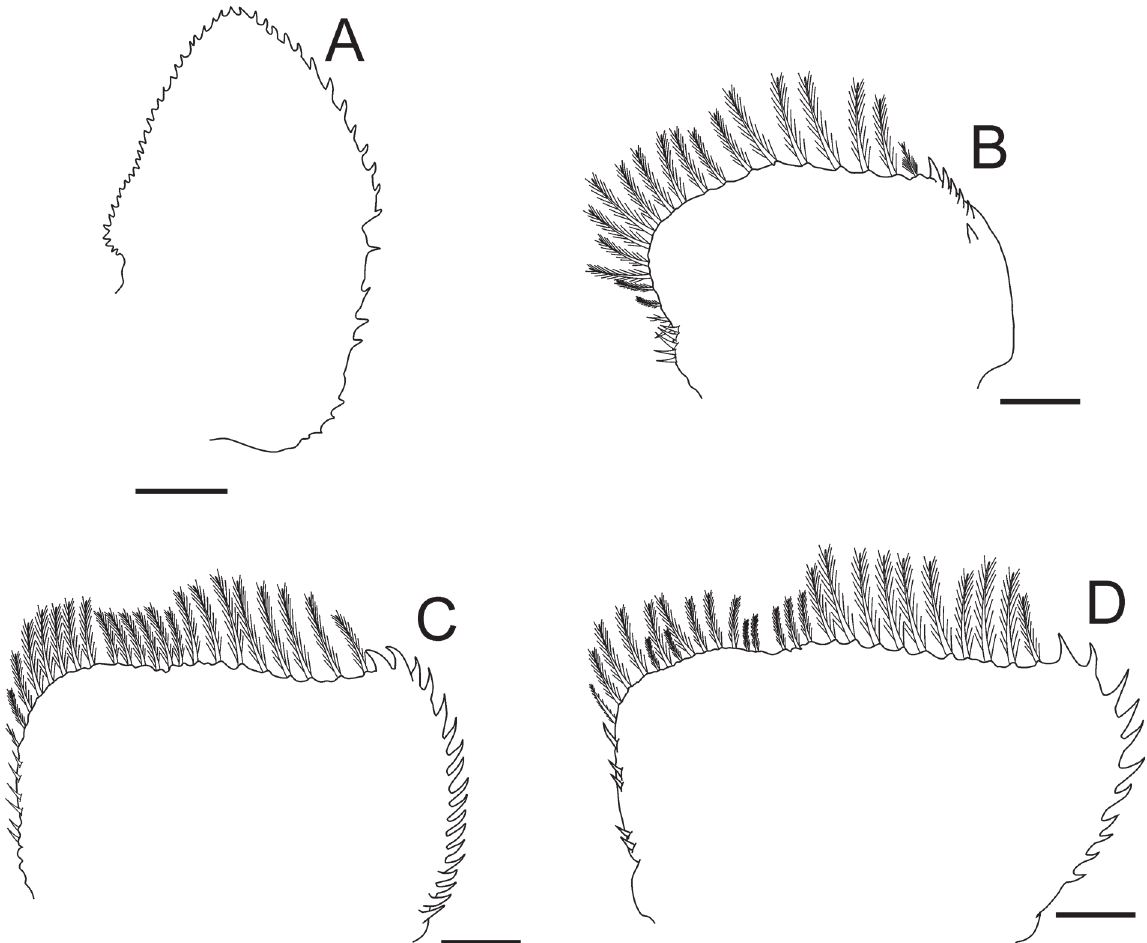
Figure 5. Dendrocephalus brasiliensis Pesta, 1971, male from Porto Real do Colégio, Alagoas, Brazil (CARCINO 104). A) pre- epipodite of first limb; B) endopodite of the first limb; C) endopodite of the second limb; D) endopodite of the third limb. Scale bars = 0.2